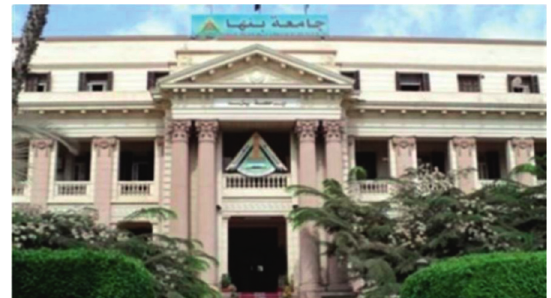
Figure 2: Khedive Abbas I Palace.